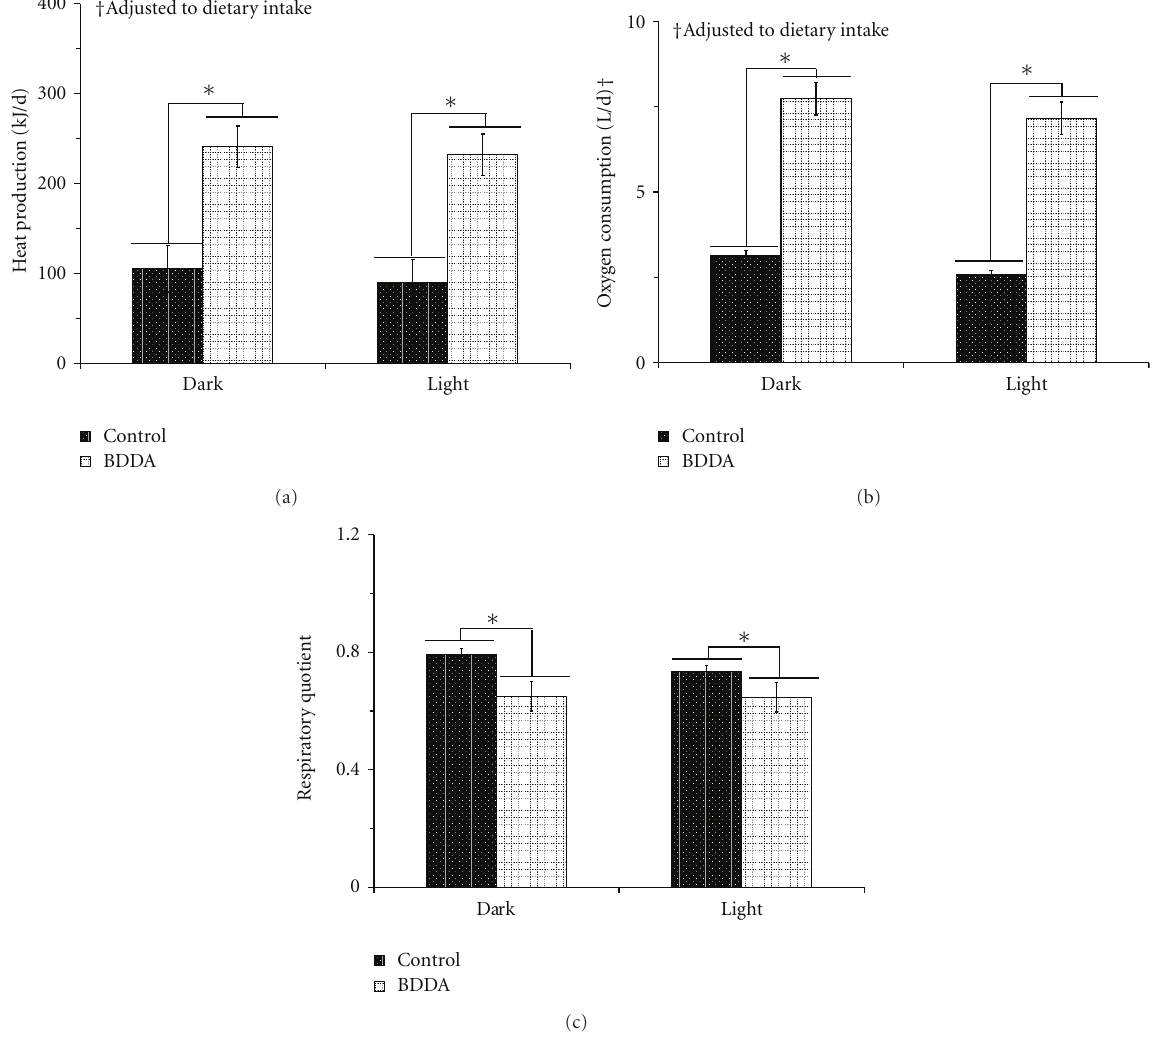
Figure 1: (+)- Z -BDDA enhanced basal metabolism and fatty acid oxidation in female OZR rats. After a 24-hour acclimation period, rats were monitored in the metabolic chambers (Accuscan Instruments Indirect Calorimeter, Columbus, OH) for 24h with unlimited access to food and water. Gas samples were collected and analyzed every 5 minutes, averaged for each hour, and presented as total for 24h period. Output parameters included heat production (kJ/d), VO 2 (L/d), and RQ (VCO 2 /VO 2 ). All measures were obtained from female OZR rats after 11 weeks of (+)- Z -BDDA treatment ( n = 8). Graphed values represent means ± SE. Asterisks ( ∗ ) represent significant di ff erences among means as determined by Student’s t -test ( P < 0 . 05). (a) Heat production expressed as kilojoules per day; (b) oxygen consumption expressed as liters per day; (c) respiratory quotient